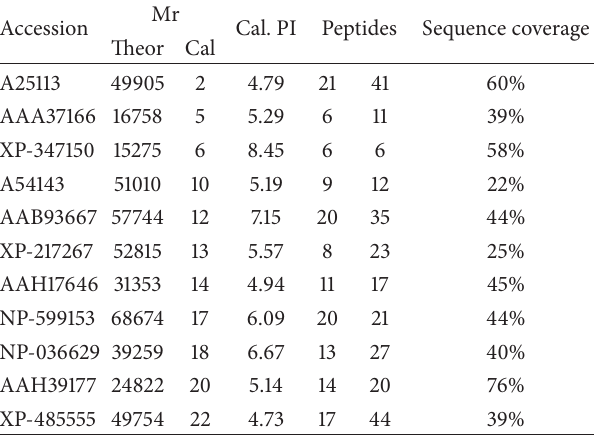
Table 1: Between-group differences in the expression of proteins in the rat hippocampus and